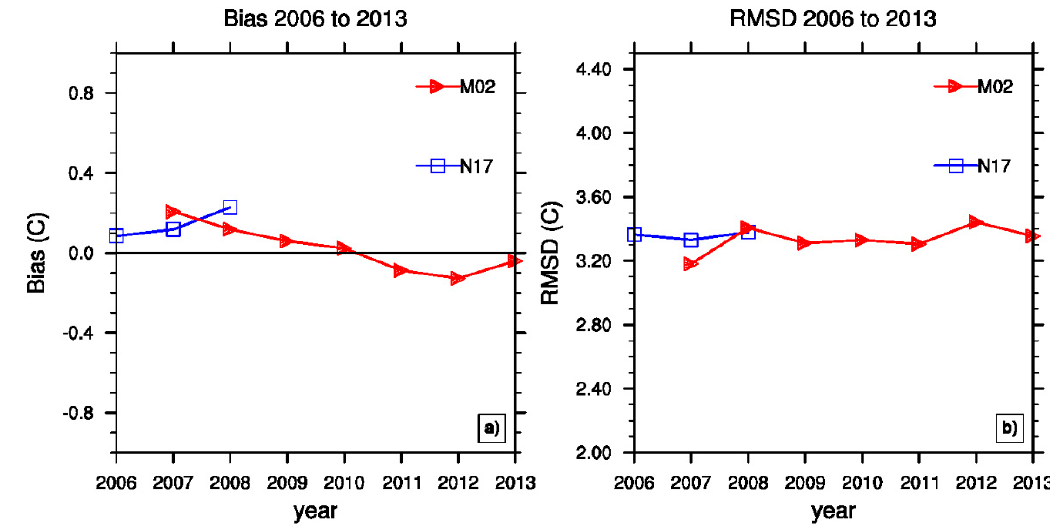
Figure 3. Annual bias ( a ) and RMSD ( b ) of HIRS M02 and N17 SATs (in °C). Each year represents the average bias and RMSD of the stations. Bias is defined here as HIRS minus USCRN.